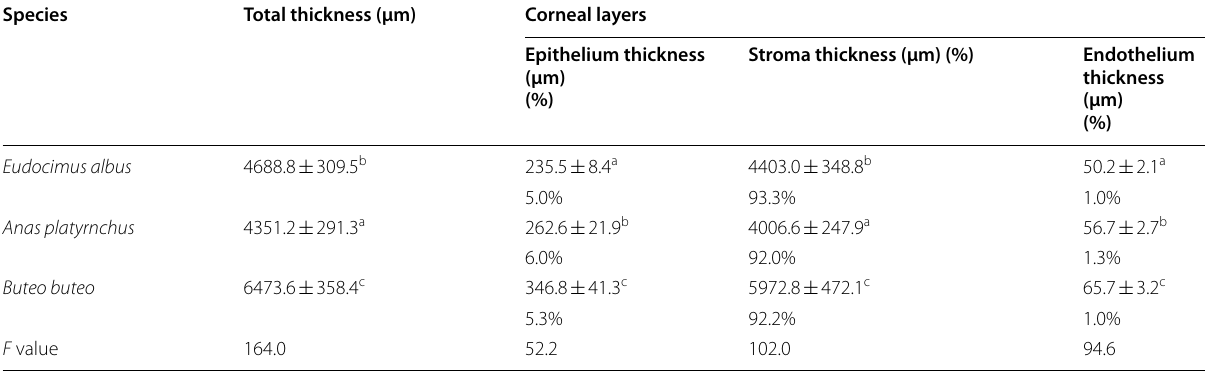
SD) of corneal layers in three Avian’s species (10 animals per species) ±